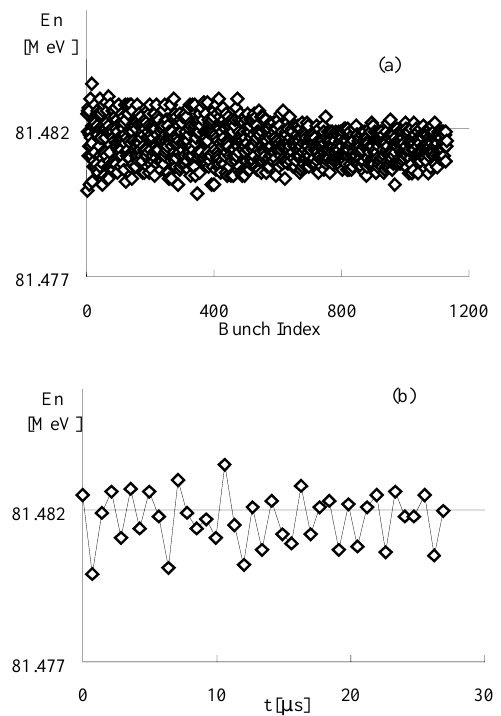
FIG. 5. (a) Energy gain for 1130 bunches accelerated with the superstructure. (b) Energy gain vs time for the first 40